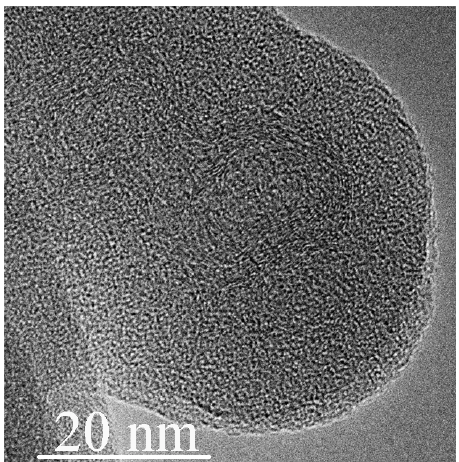
Figure 4. TEM image of the g -C 3 N 4 specimen after shear deformation at 53–57 GPa.